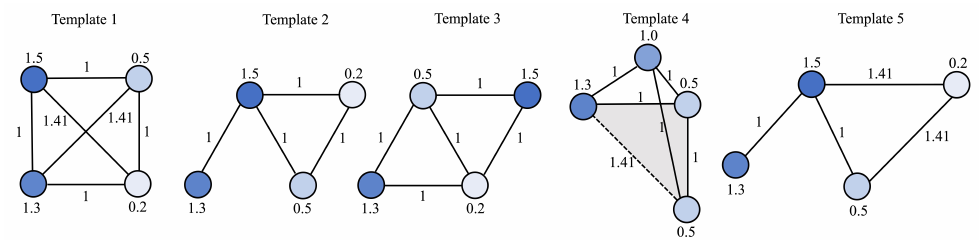
Figure 3. Five templates used to generate the synthetic datasets. Template 2 and 5 are designed to make the classification task more challenging, in which only two edges take different attributes.